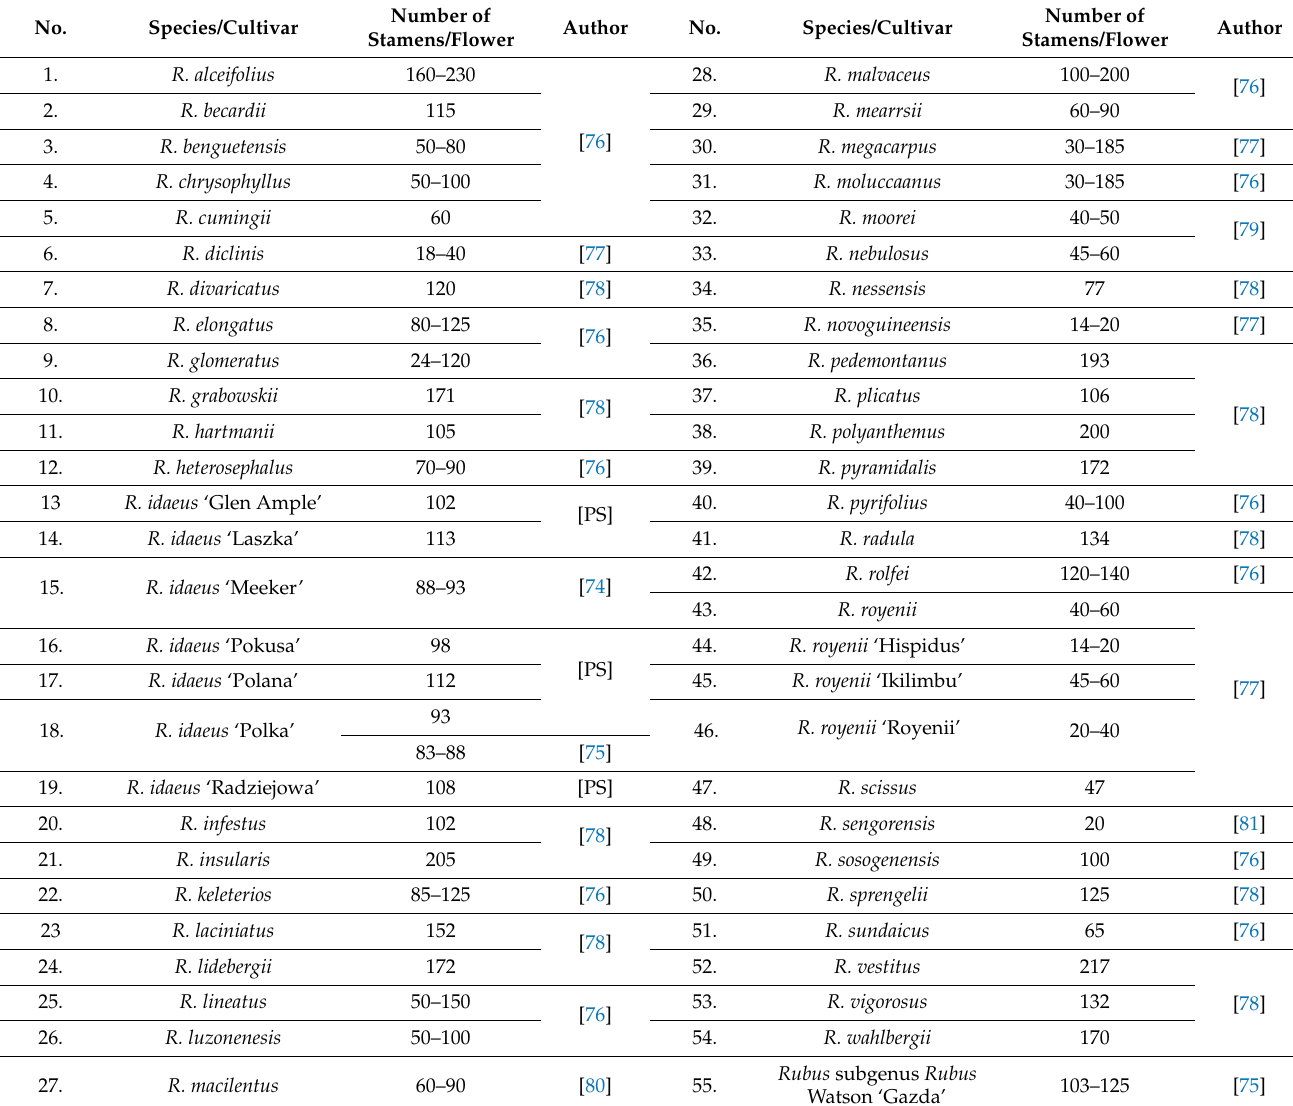
Table 5. Number of stamens in flowers of selected Rubus